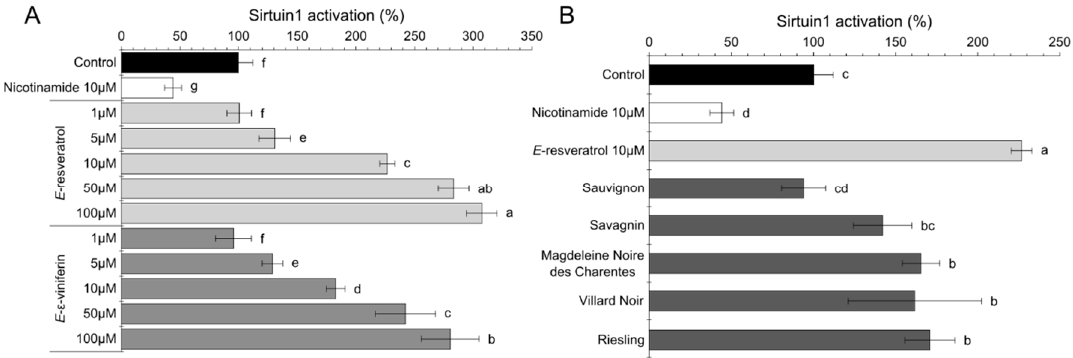
Figure 2. Sirtuin activation results for pure stilbenoids ( E -resveratrol, E - ε -viniferin) and nicotinamide ( A ) and for the GCE (50 µ M) from five cultivars ( B ). Data are mean values ± standard deviation ( n = 3). Different letters indicate significant difference between means at p < 0.001.